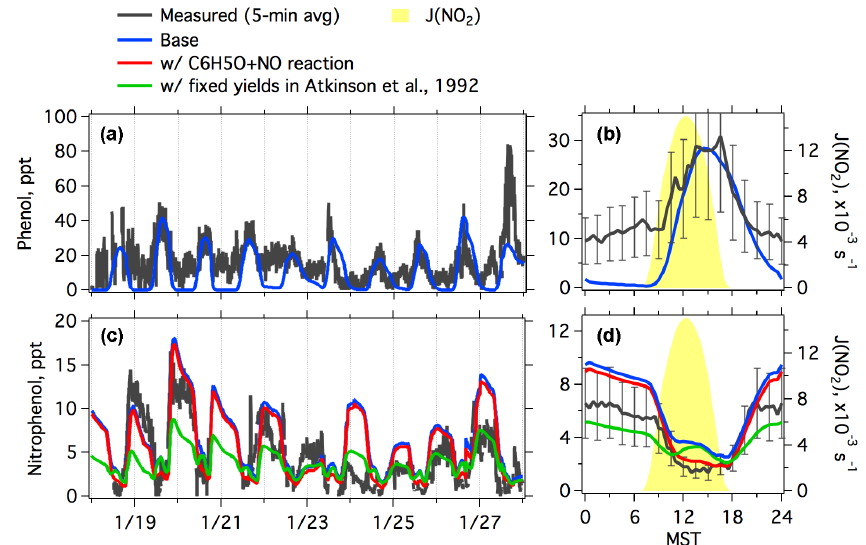
Figure 5. ( a , c ) Comparison of measured and modeled time series of phenol (a) and NP (c) . ( b , d ) Diurnal profiles of measured and modeled concentrations of phenol (b) and NP (d) . Photolysis frequencies of NO 2 are shown in (b) and (d) for reference. Error bars in (b) and (d) indicate the accuracies of measured concentrations of phenol (50%) and NP (40%),